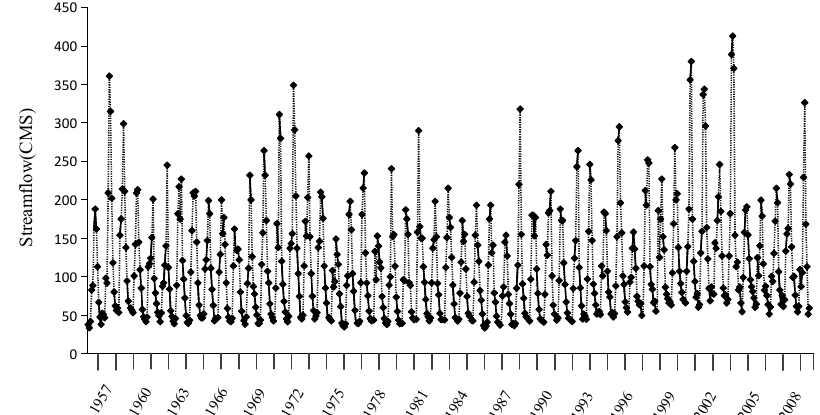
Figure 2. The Kaidu River Basin.